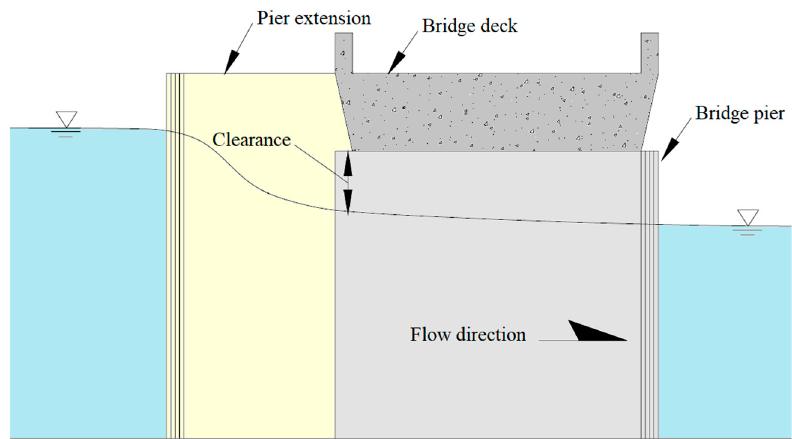
Figure 1. Bridge with pier extension.